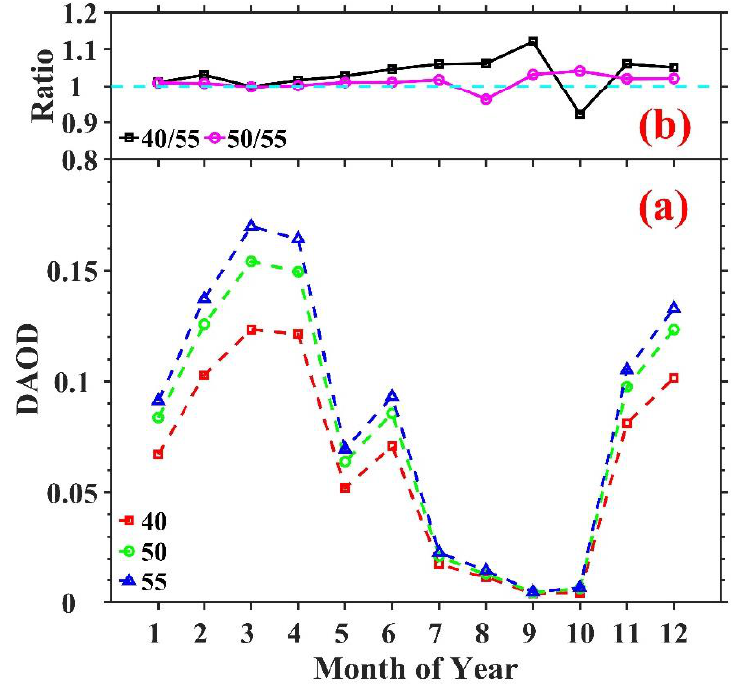
Figure 7. The seasonal cycle of ( a ) dust aerosol optical depth (DAOD) with lidar ratios of 40 sr (red line), 50 sr (green line) and 55 sr (blue line) for MPL measurements at the NSA site from January 2013 to September 2017. ( b ) The ratio of DAODs with different lidar ratios (cyan line is the reference line, black line is the ratio of 40 and 55, magenta line is the ratio of 50 and 55).